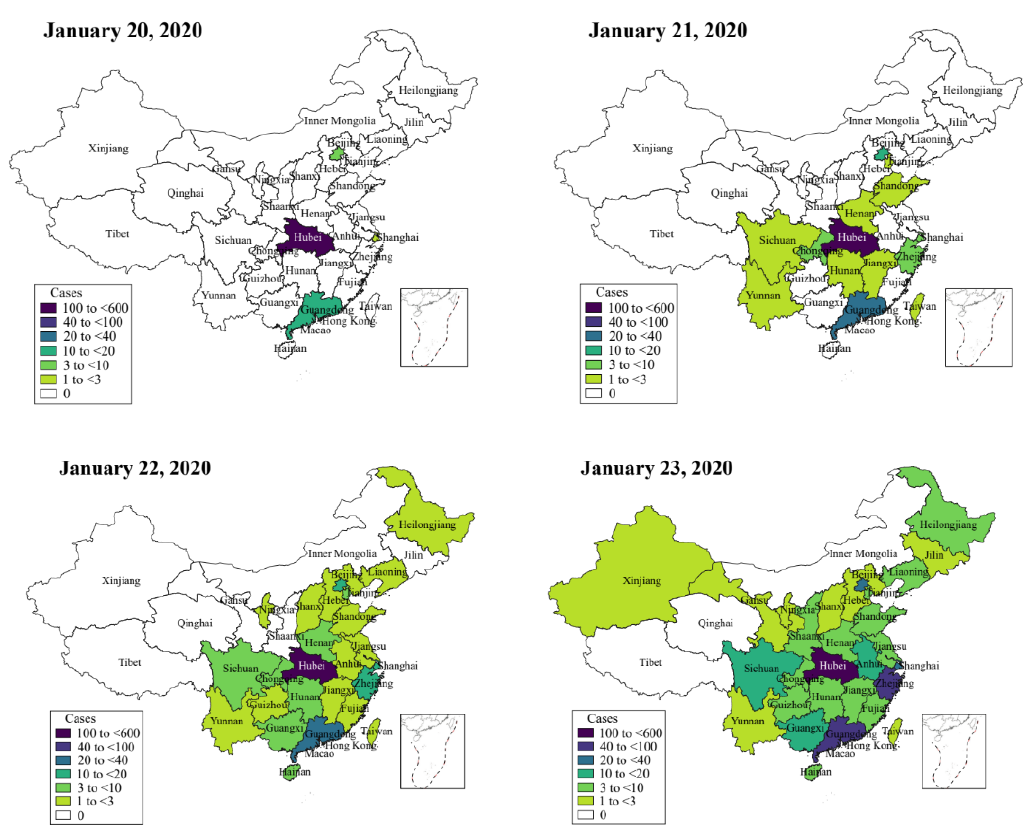
Figure 5. Heat-map showing the spreading of the Coronavirus infection.